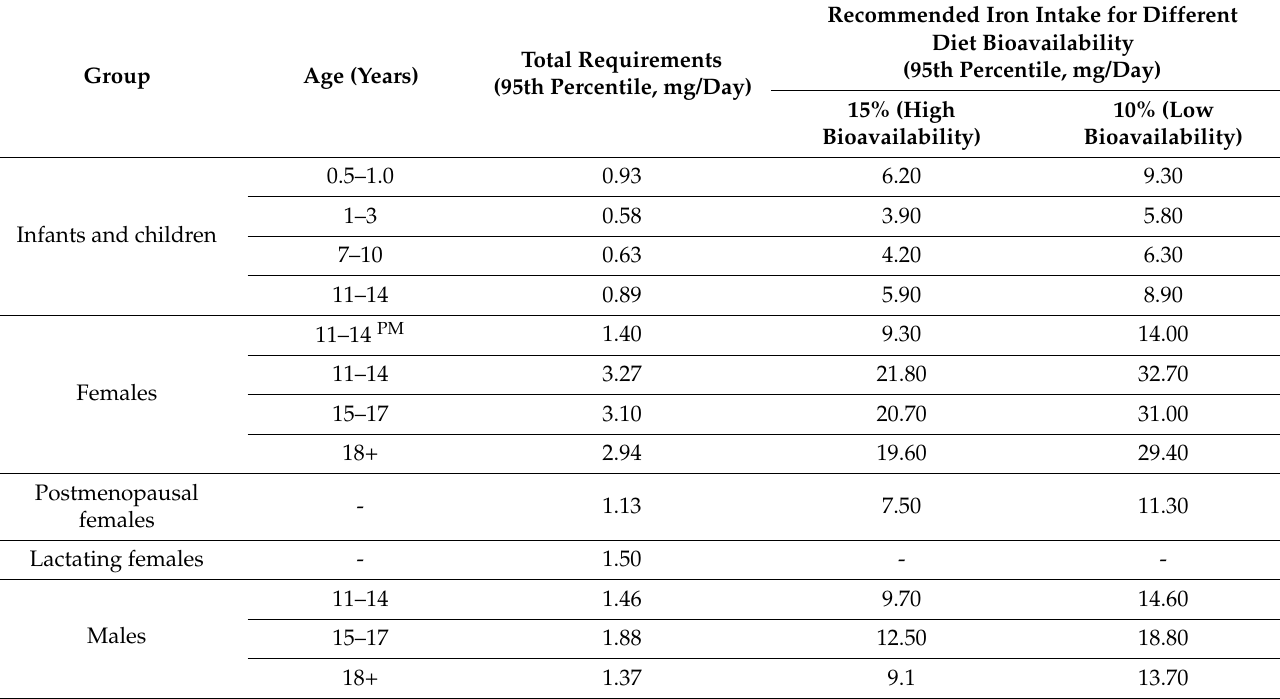
Table 2. Iron requirements and recommended iron intake for different diet bioavailability [34].